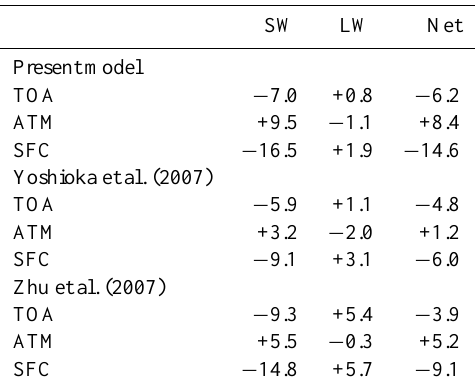
Table 1. Comparison of model areal mean radiative forcing of with previous models and observations. TOA=top of atmosphere, ATM=atmosphere, and SFC=surface. Positive downward for TOA and SFC, positive for absorption in ATM. All dust optical thick- nesses have been scaled to 0.20. Unit is in Wm − 2